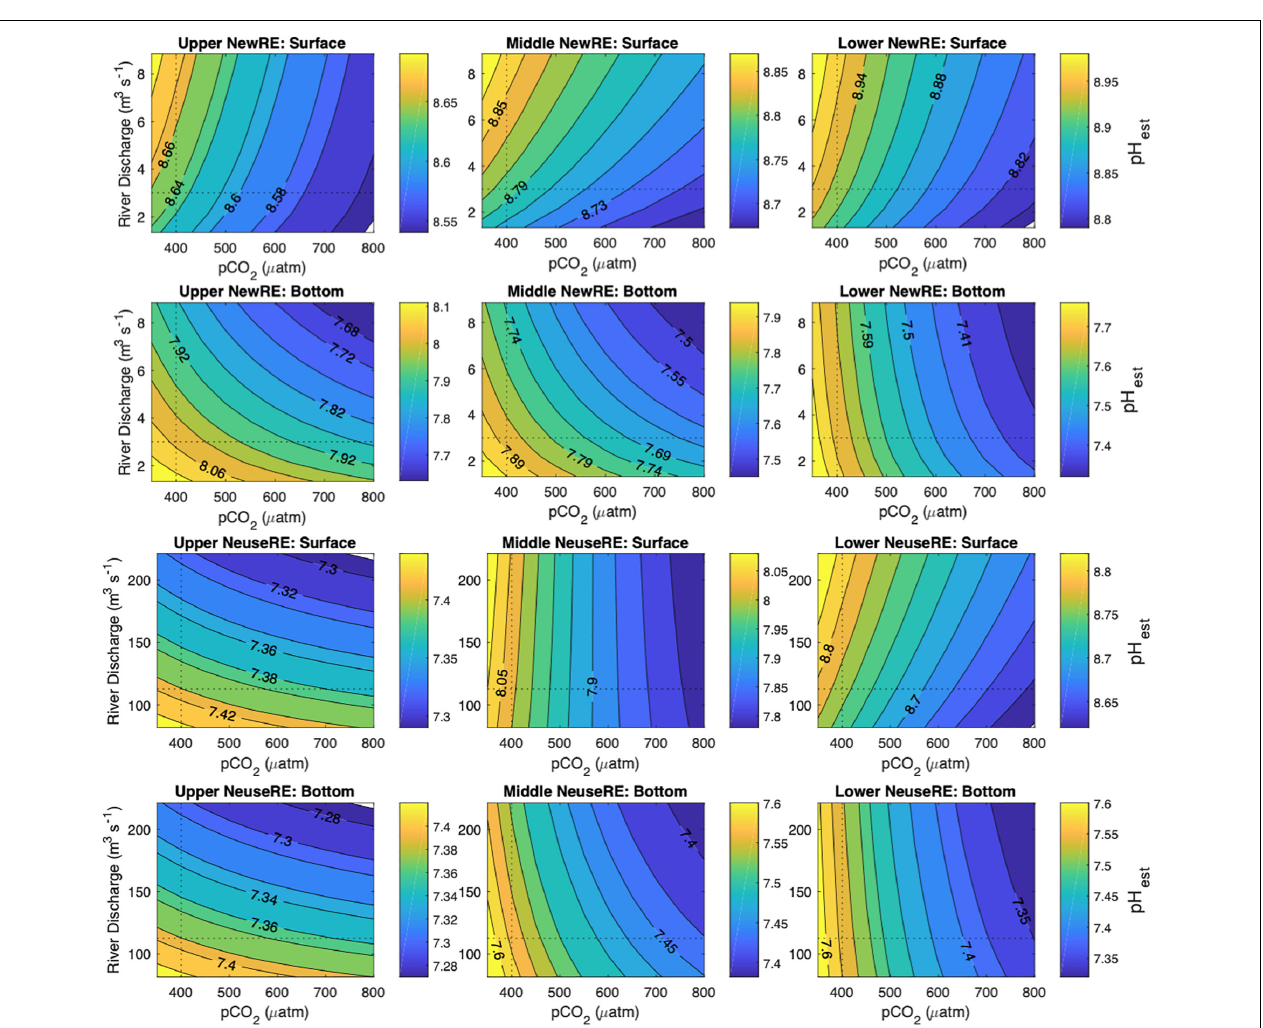
FIGURE 3 | Model pH est as a function of atmospheric pCO 2 ( µ atm) and river discharge (m 3 s − 1 ), where pH est values are shown by the colored contours. Model results are shown for surface and bottom estuarine boxes, for the regions described in the Supplementary Material .